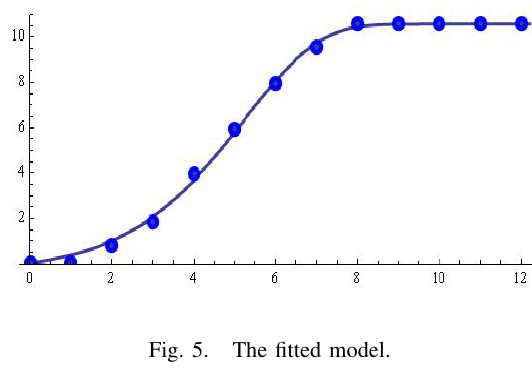
Fig. 5. The fitted